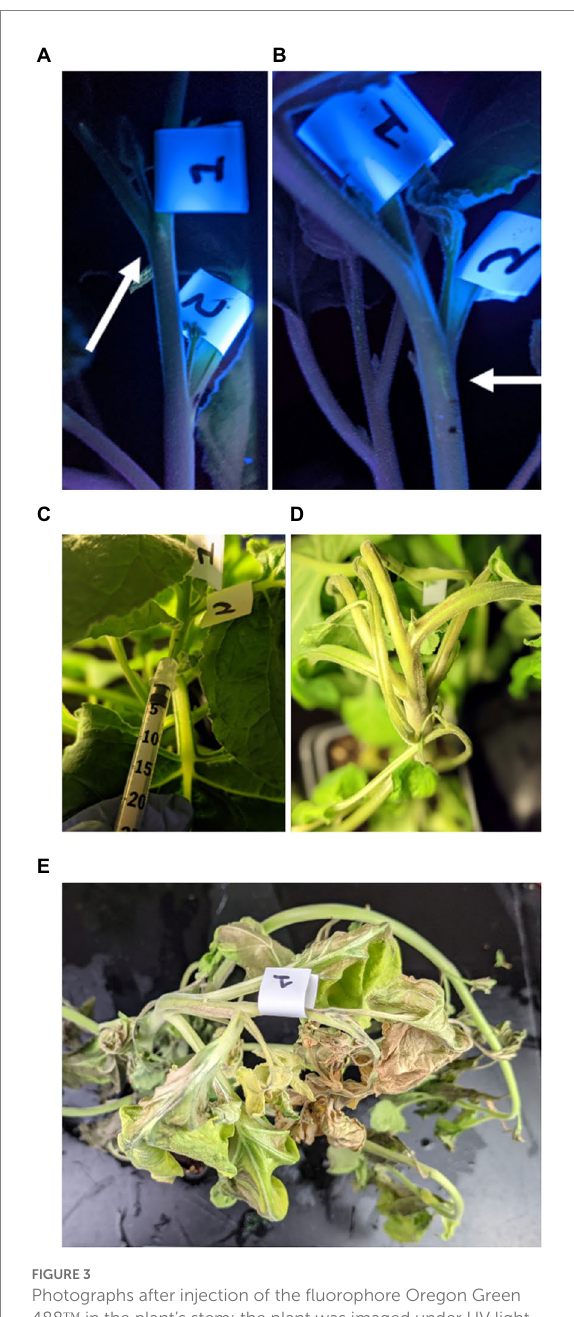
FIGURE 3 Photographs after injection of the fluorophore Oregon Green 488 ™ in the plant’s stem; the plant was imaged under UV light (A,B) . Photographic documentation of TMV injection into the stem (C) . After the inoculation, early signs of necrotic tissue were observed in the stem, on average 8 days post infection (D) , which would expand causing leaf necrosis and death (E) . Therefore, viral syringe inoculation into the stem is not a suitable method for an infectious vector – it may be suitable for non-infectious